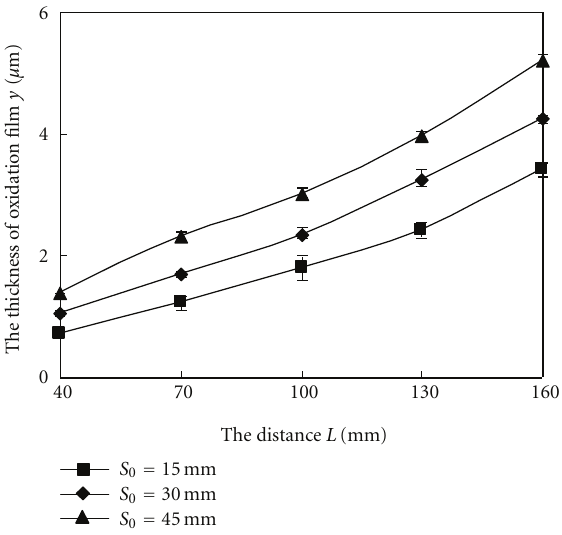
Figure 5: Thickness distribution of oxidation film on tapered pipes surface for di ff erent feed